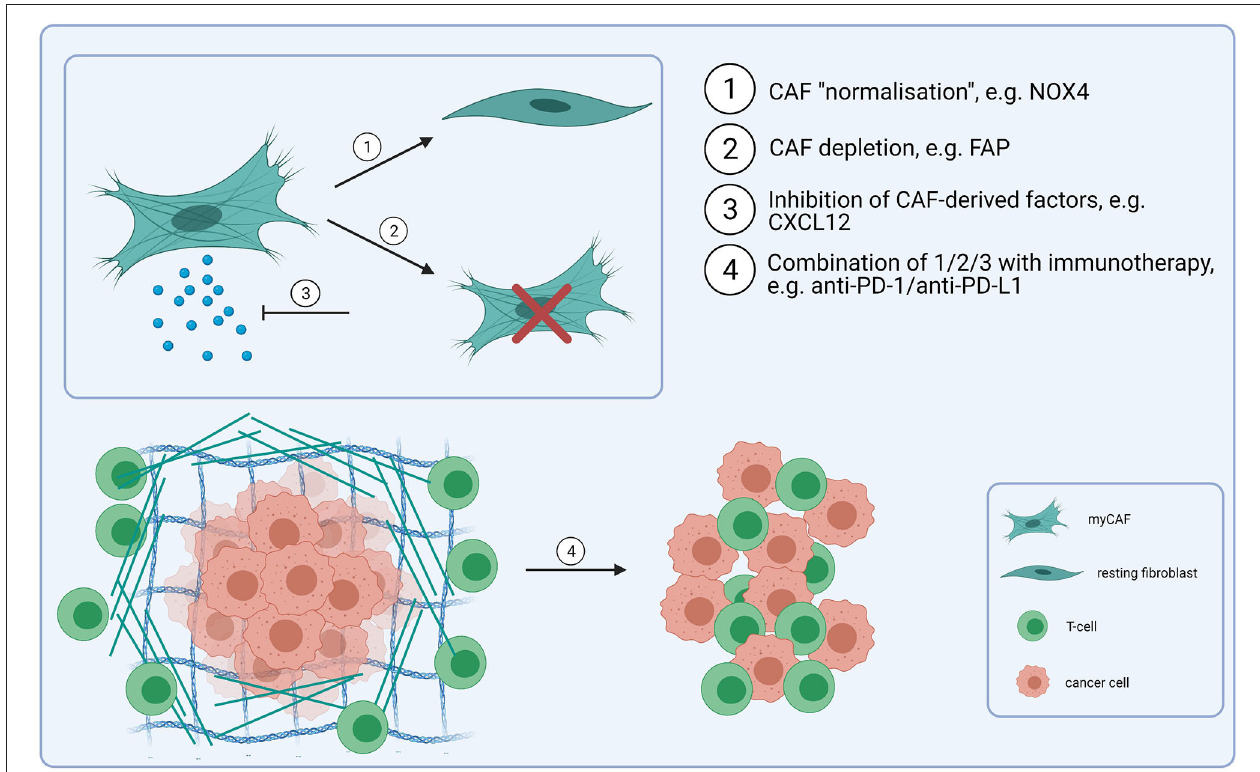
FIGURE 2 | CAF-targeting strategies. Combining immunotherapy-based treatmens (e.g., anti-PD-1/anti-PD-L1) with CAF-targeting, either through CAF “normalisation” (1) (e.g., NOX4 inhibitors), depletion (2) (e.g., FAP-based depletion) or through disrupting a signalling network between CAF and cancer